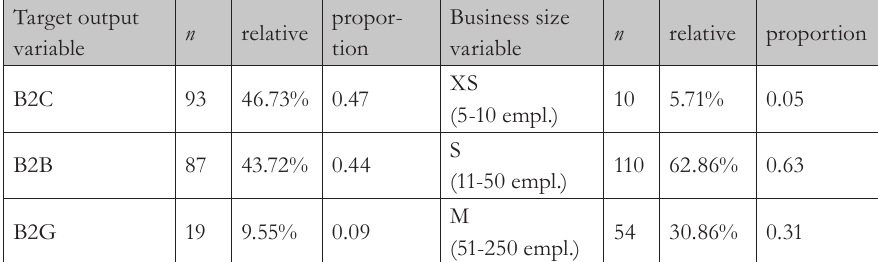
Tab. 1 – Target group characteristics: Business size distribution - Number of